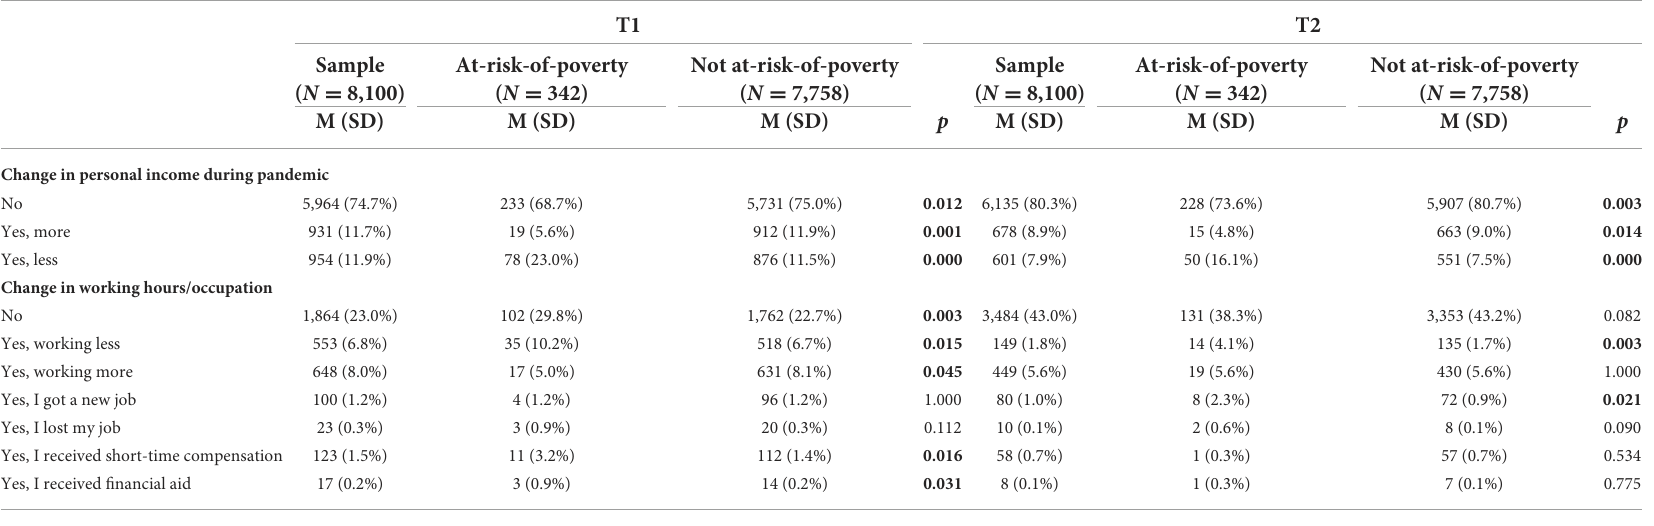
TABLE 2 Changes in income and employment during the COVID-19 pandemic for men and women living and not living at-risk-of-poverty ( N = 8,100). At-risk-of-poverty T1 T2 Sample At-risk-of-poverty Not at-risk-of-poverty Sample At-risk-of-poverty Not